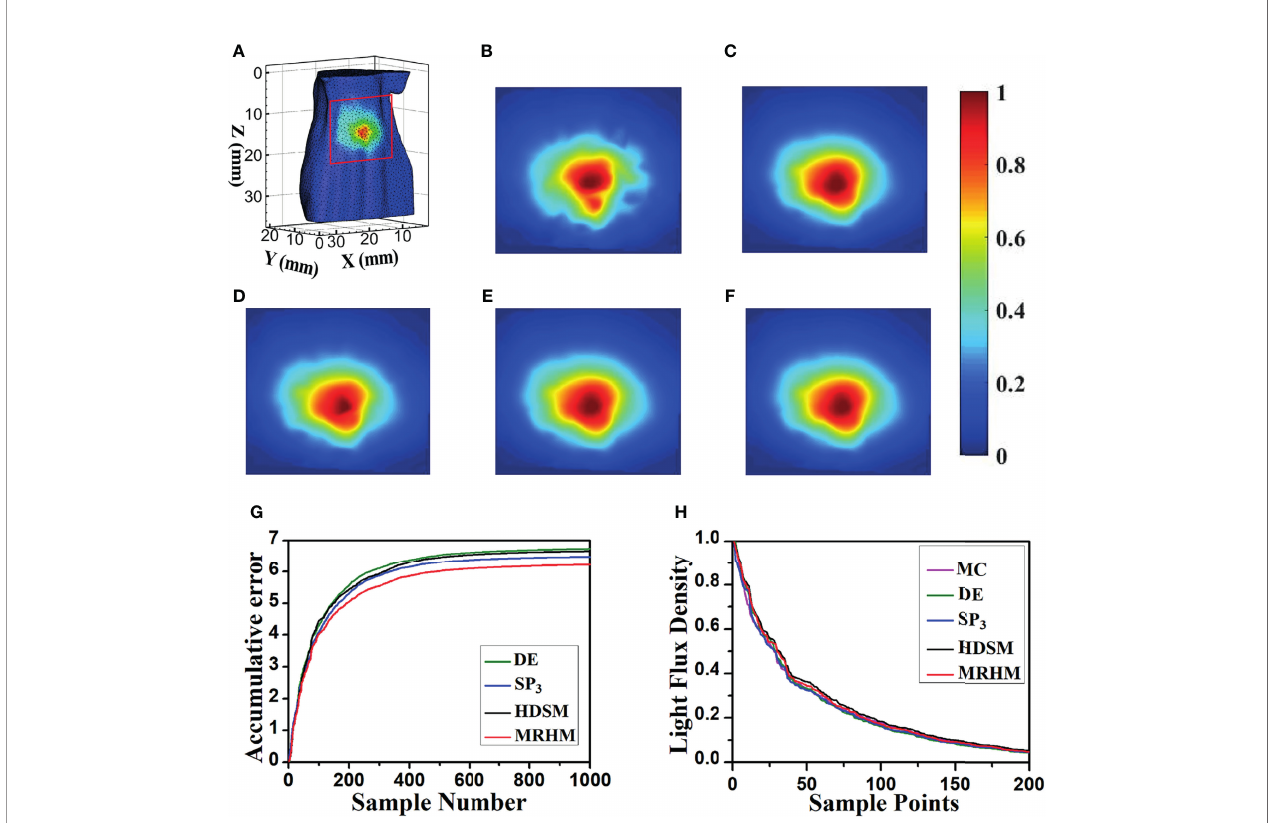
FIGURE 6 | Results of forward simulation at 630 nm. (A) The surface luminescence fl ux illustration of the digital mouse model. (B – F) The surface luminescence fl uxes projected onto the X – Z plane simulated by the MC, DE, SP 3 , HDSM, and MRHM, respectively. (G) Accumulative error for each model. (H) The descending order of surface light fl ux of each model.